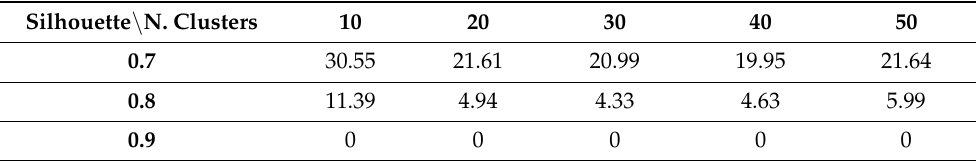
Table 42. Clustering performance in terms of silhouettes using the reduced dataset with SPQR applied to normalized data.